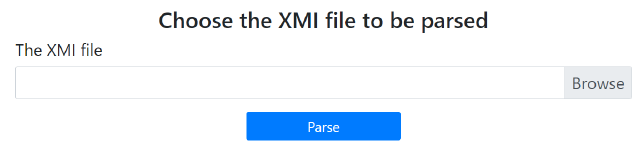
Figure 9. The organization of the source code of the parser.